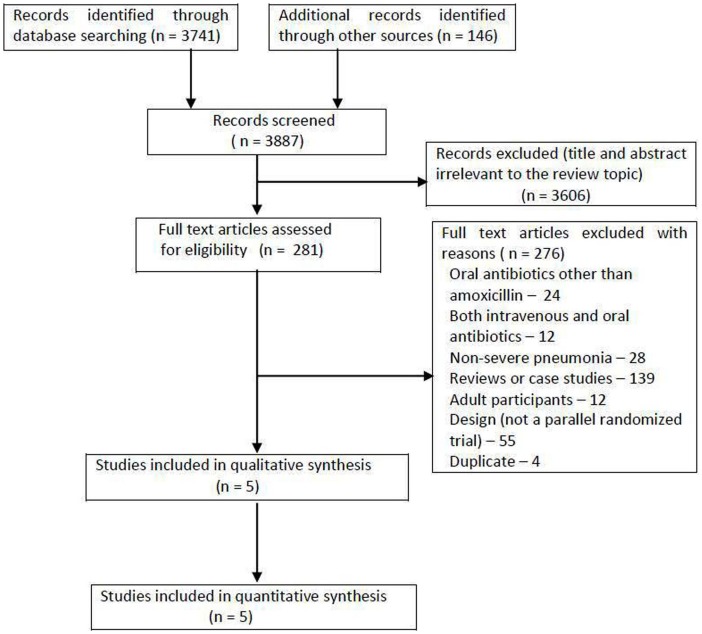
Flow diagram of search results.